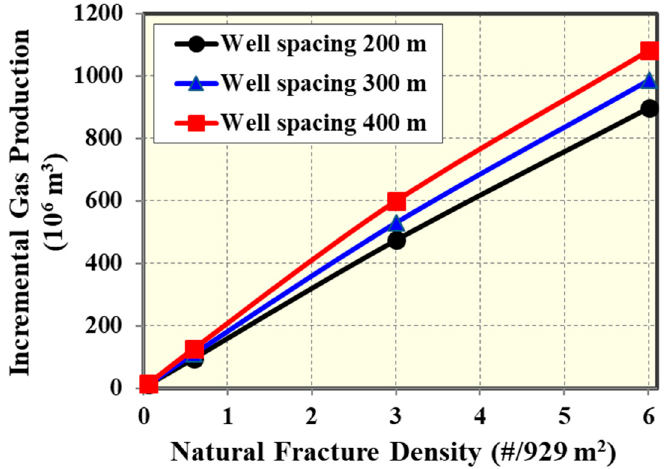
Figure 11. Effect of natural fracture density on the incremental gas production after 30 years under different well spacing.